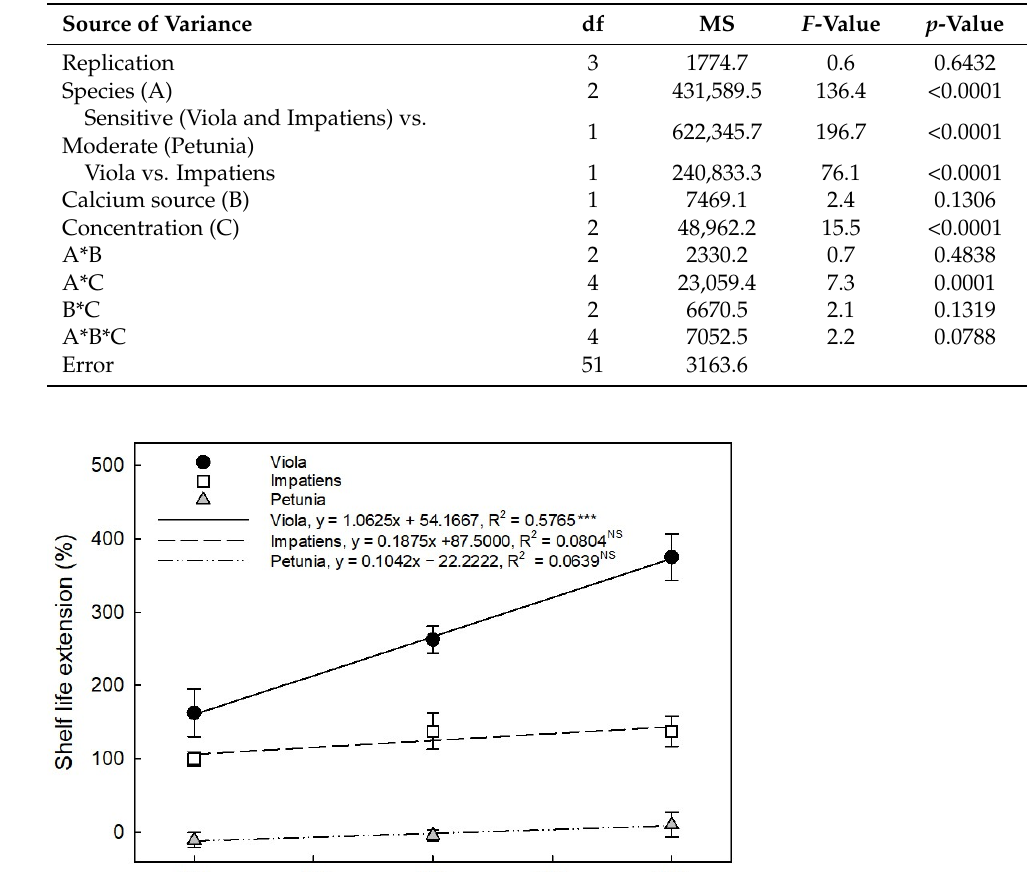
Table 3. Factorial ANOVA on shelf life extension in pre-drench application.